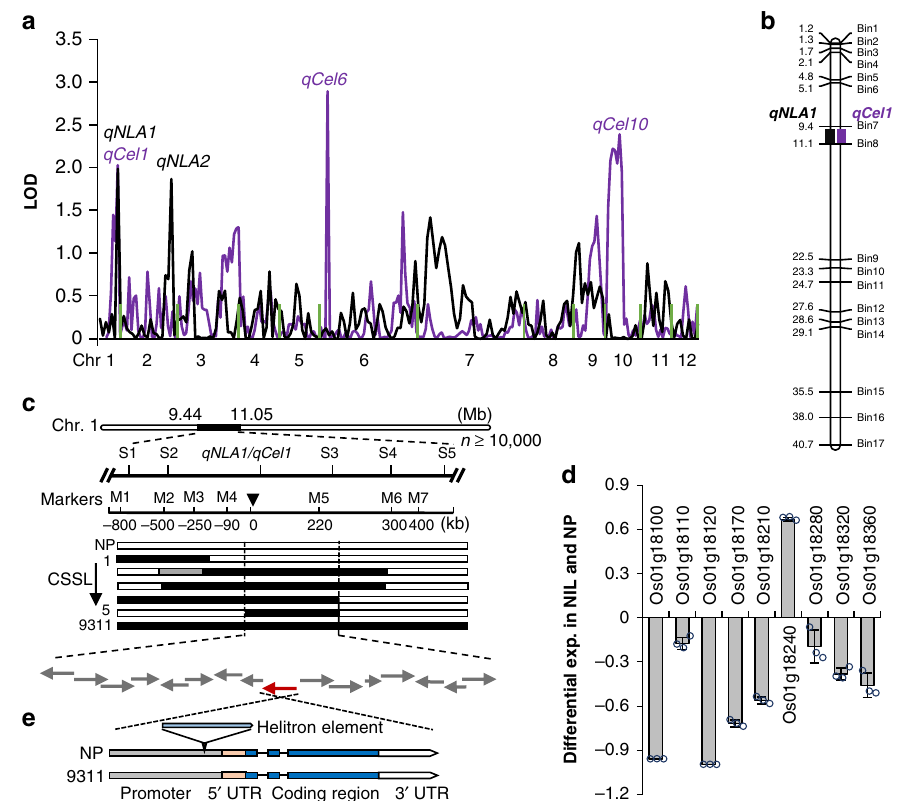
Fig. 2 Cloning of qNLA1/qCel1 . a QTL analyses of nitrogen-mediated leaf area changes ( qNLA , black line) and cellulose content ( qCel , purple line) in the 9311 introgression lines with NP background. The green lines were used to separate individual chromosomes. b qNLA1 is colocalized with qCel1 . Different symbols indicate the positions where the corresponding QTL are located. The numbers on the left side of chromosome indicate physical locations (Mb). c Mapping of qNLA1 and qCel1 in the backcross population. The numbers on chromosome 1 indicate the physical locations. S1 – S5 and M1 – M7 indicate molecular markers used for mapping. The black and white rectangles represent 9311 and NP genomic region, respectively. Arrows represent candidate genes within the 231.8 kb pin-pointed region according to the performance of the CSSL recombinants (1 to 5) shown in Supplementary Fig. 2f, g. d The expression differential ratio of the candidate genes in the NIL to NP plants. Rice HNR was used for normalization of the expression of the examined genes. Error bars represent the mean ± SD of three biological replicates. e The variation at Os01g18240 gene. A helitron element is present in the promoter of the NP allele. Source data underlying Fig. 2d are provided as a Source Data fi